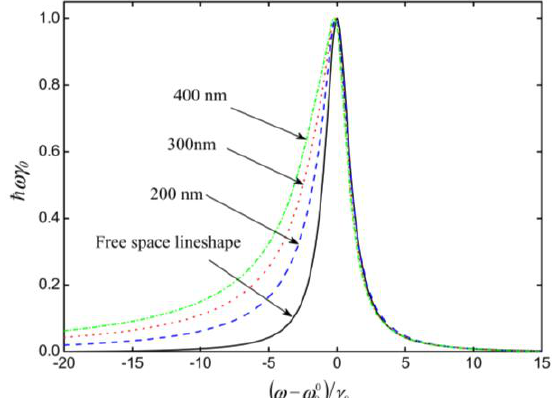
Figure 4. Frequency dependence of the fluorescence power from a Cs cloud coupled into an ONF, including contributions from the van der Waals and the Casimir-Polder effects. For this calculation a cloud radius of 400 nm has been used. The nanofiber radius is varied from 200 nm to 400 nm for the different plots. The solid line shows the expected free space line shape as a comparison. Note that all lines are normalized. Reprinted with permission from [35]. Copyright 2009 Institute of Physics.